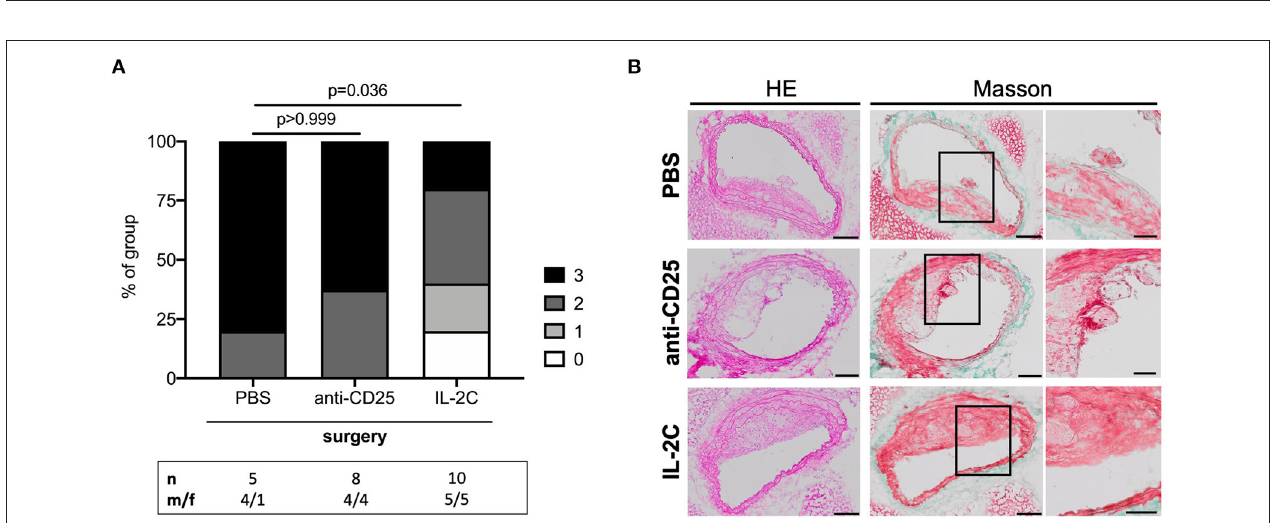
FIGURE 6 | as buried FC. (C) Immunofluorescent stainings showing representative images of buried FCs in mice treated with anti-CD25 mAb, that were subjected to sham or surgical intervention, respectively (scale bar 100 µ m). High-magnification images are shown for box-indicated regions (scale bar 50 µ m). The total number of mice under study as well as the ratio of male to female mice is indicated per group. Mice presenting with a maximum stenosis < 10% and outliers identified by ROUT were excluded from the analysis resulting in n = 5–10 mice per group. Two-tailed Mann-Whitney U was used to compare sham and corresponding intervention groups; Kruskal-Wallis test was performed to assess differences between surgical intervention groups (gray; SMC content p = 0.178; buried FC p = 0.575).